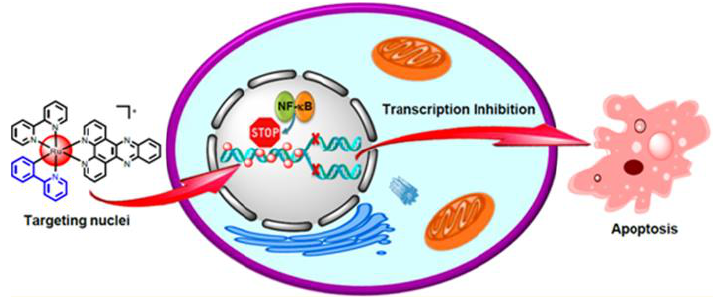
Figure 27. Representation of [Ru(bpy)(phpy)(dppz)] + nucleus-targeting activity. (Reprinted with permission from ref. [108]. Copyright 2014 American Chemical Society).